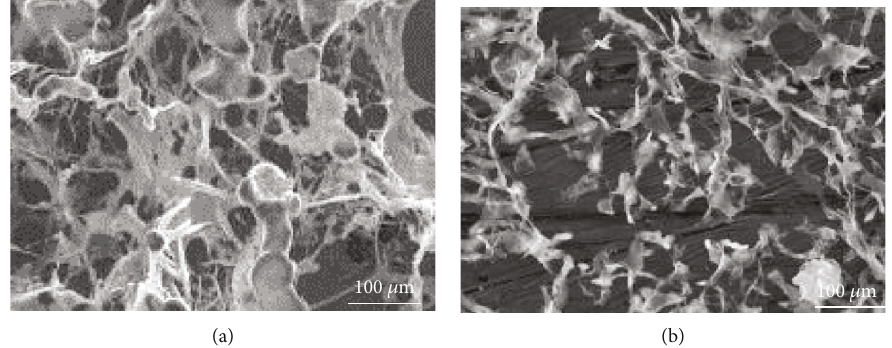
Figure 10: Microphotographs of the polymeric surfactant before and after the addition of a binary composite system: (a) PS, Cp (600mg/L), 500 times magni fi cation; (b) PS+S/P (polymer 1000 mg/L + 0 : 3 % surfactant), 500 times magni fi